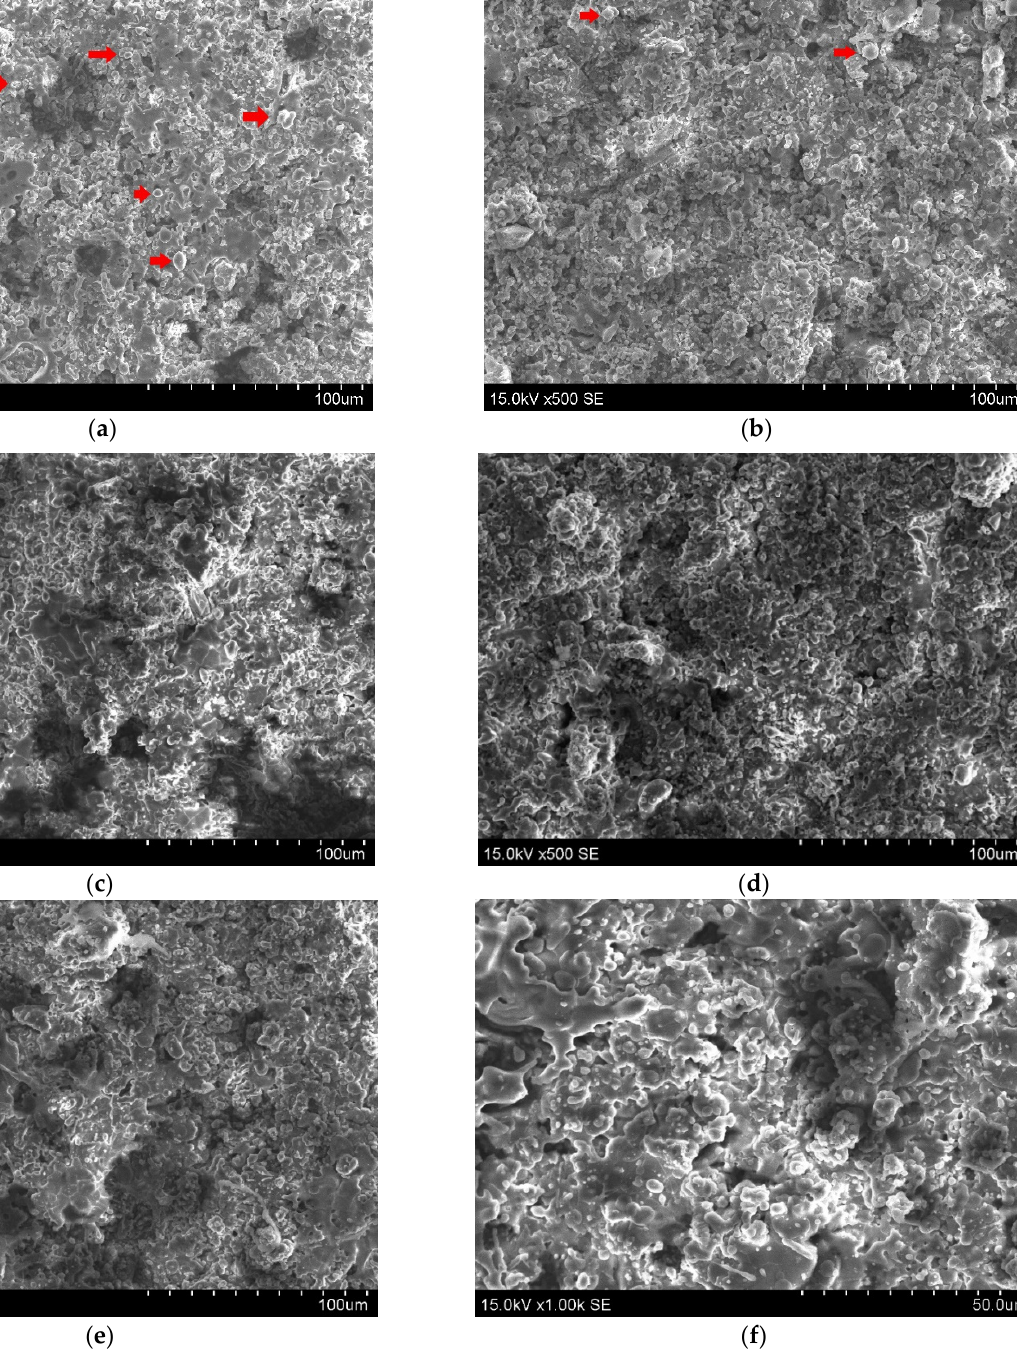
Figure 5. SEM micrographs of coating surface, using different plasma torch input powers: ( a ) 29.4 kW; ( b ) 33.6 kW; ( c ) 37.8 kW; ( d ) 42.0 kW; ( e ) 45.1 kW ; and ( f ) 45.1 kW.